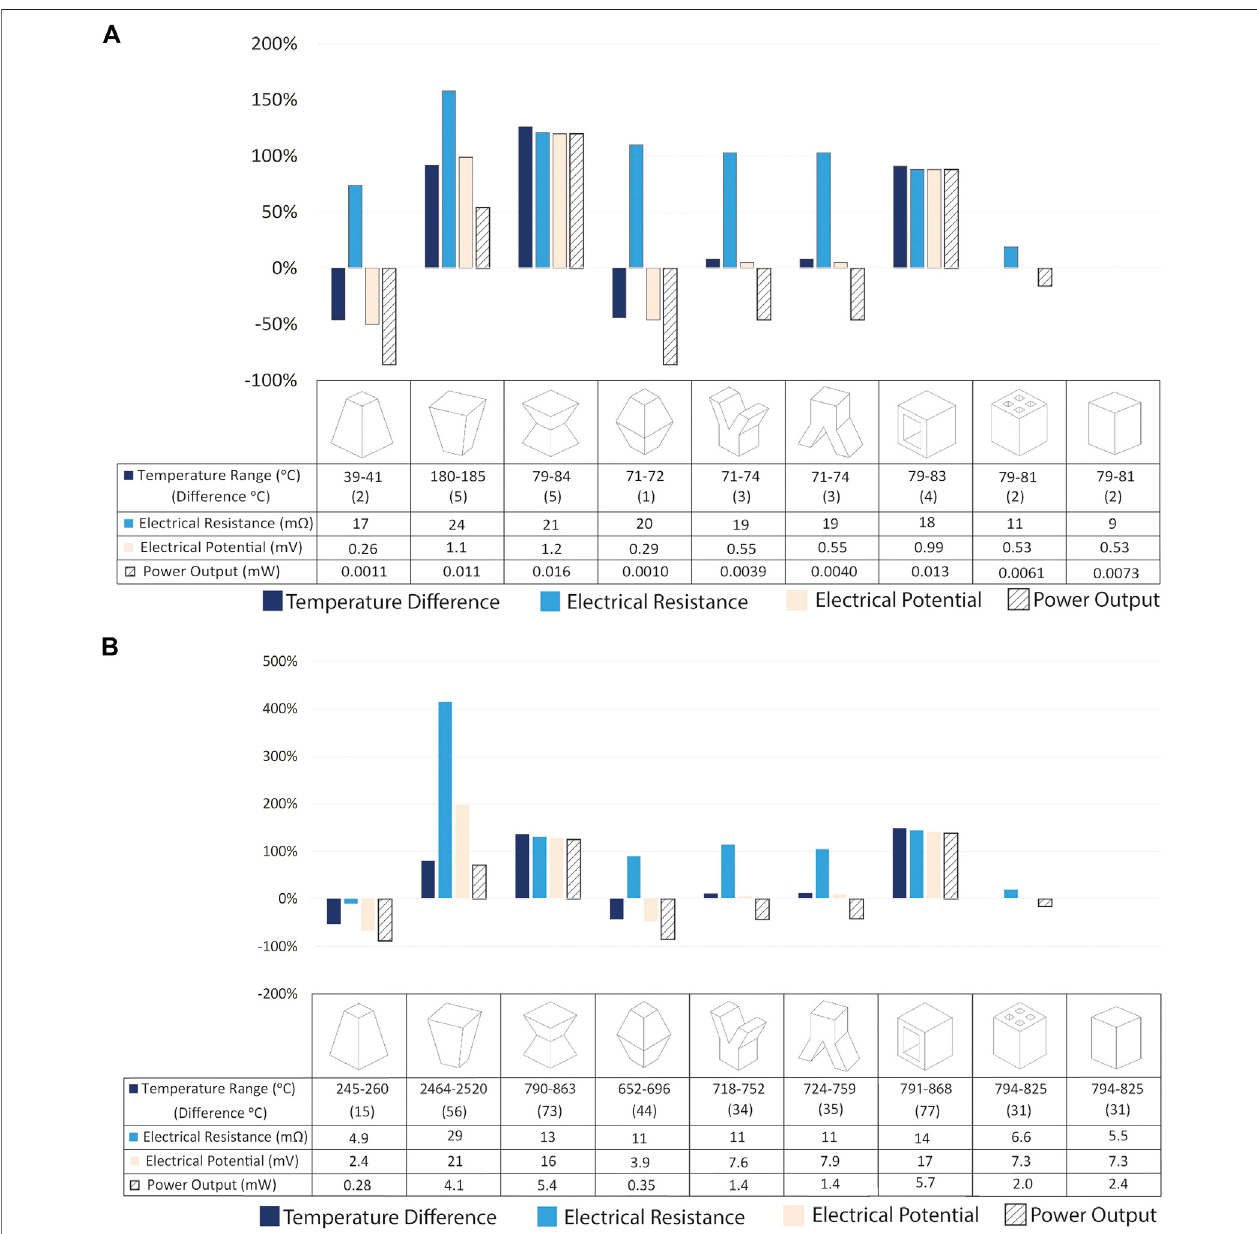
FIGURE 8 | The percent change in the temperature range across each leg, leg electrical resistance and potential, and maximum power generation potential comparedtothoseforarectangular(conventional)shapedlegareshownforconstanthotsideheat fl ux( Q h ” )andcoldsidenaturalconvectionboundaryconditionfor (A) (Bi 0.5 Sb 0.5 ) 2 Te 3 ( Q h ” (cid:1) 625 W/m 2 ) and (B) Si 0.78 Ge 0.22 ( Q h ” (cid:1) 10,000 W/m 2 ) legs of varying shapes. The tables below the plots show the computed values of the performance